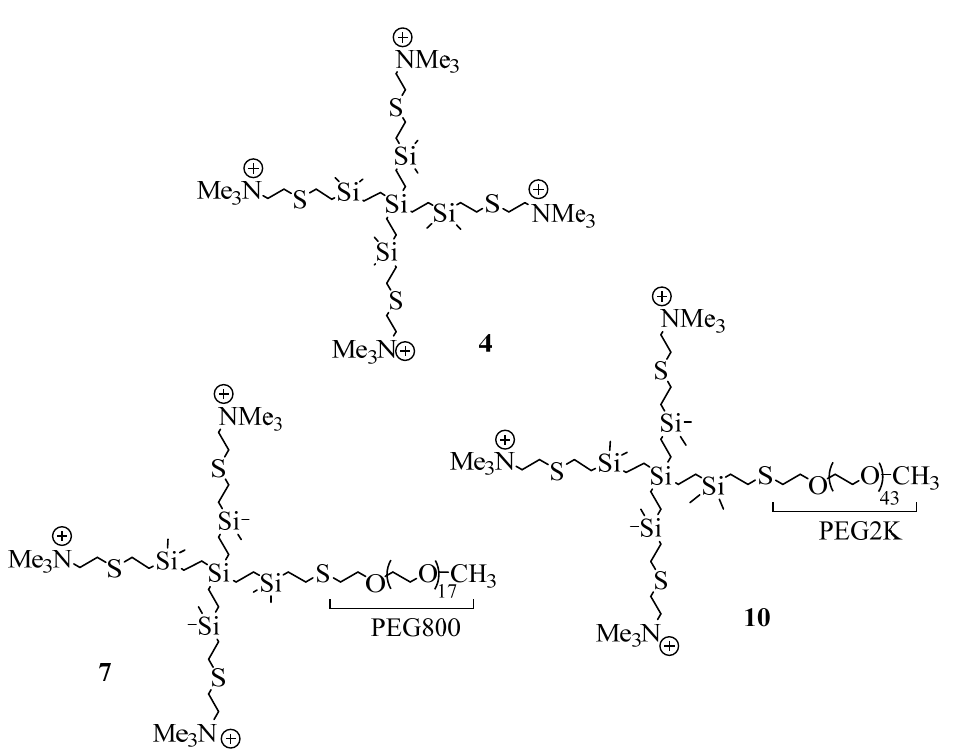
Figure 2. Drawing of cationic CBS dendrimers homo- ( 4 ) and heterofunctionalized with PEG-800 ( 7 ) and PEG-2000 ( 10 ) used in this work.